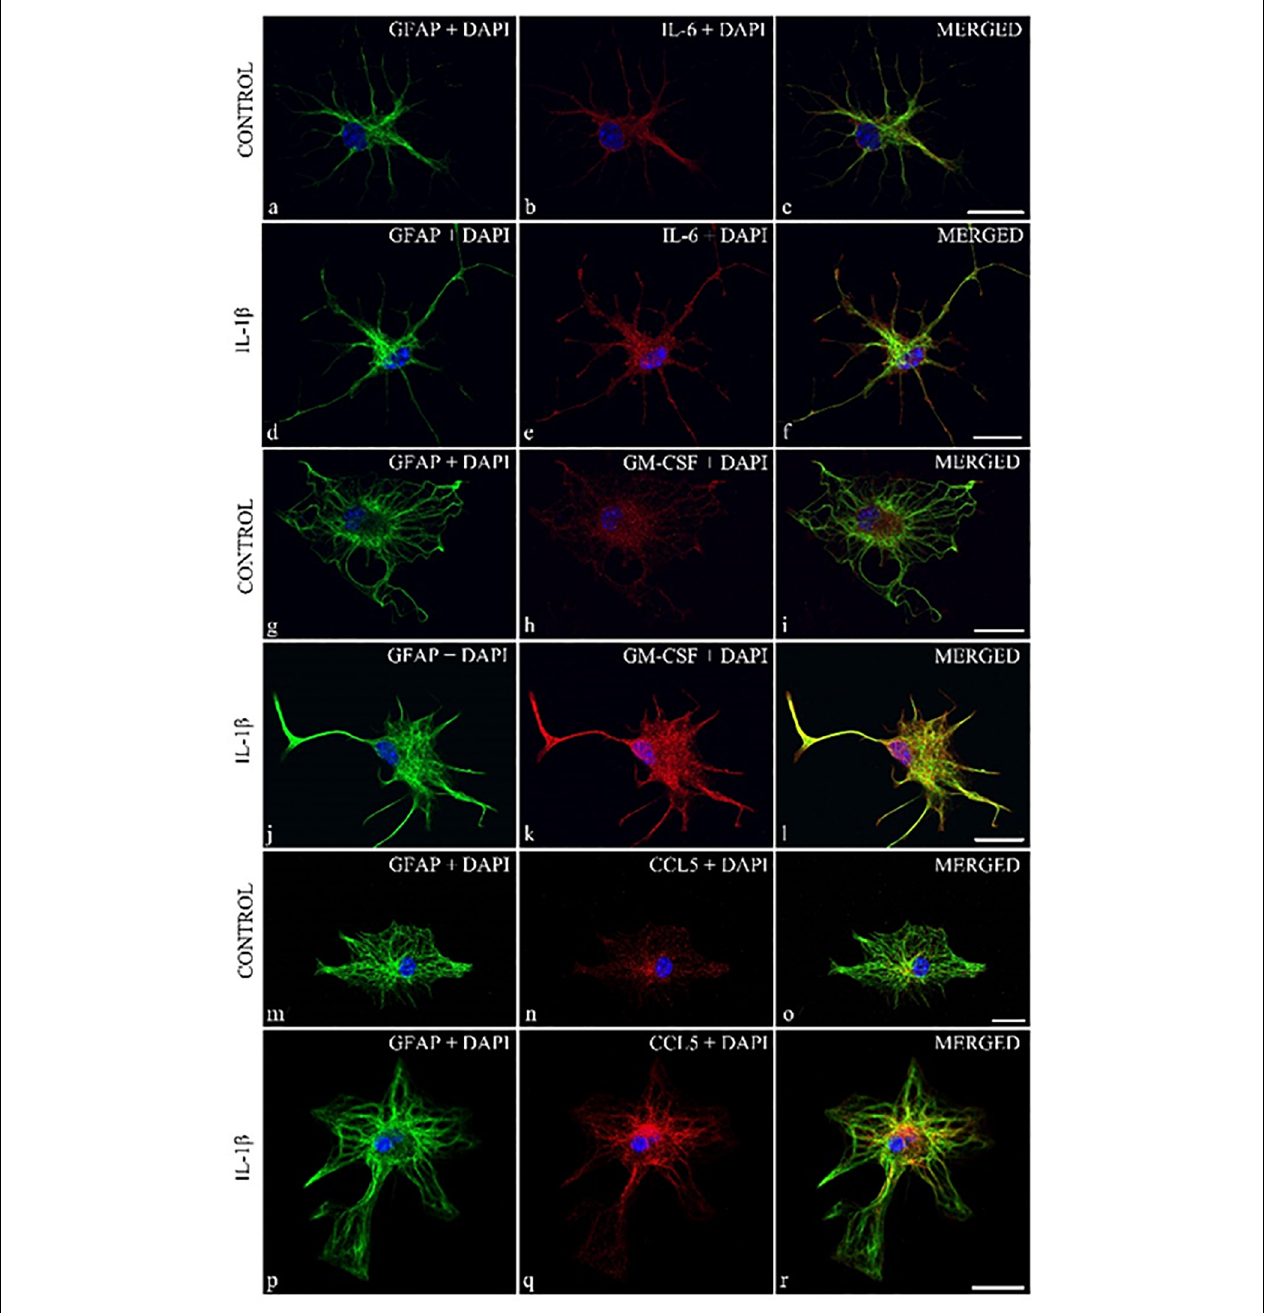
FIGURE 5 | Localization of cytokines in cytoplasmic compartment of GFAP + spinal astrocyte cultures: enhanced cytokine expression was observed in IL-1 β stimulated spinal astrocytes. Micrographs of single 1 µ m thick laser scanning confocal optical sections illustrating co-localization between GFAP astrocytic marker (green) and IL-6, GM-CSF, CCL5 cytokines (red). Panels (a–c , g,h , l–n) represent control, while (d–f,i–k,o–q) show cultures which received 24 h of IL-1 β treatment. Mixed colors (yellow) on the superimposed images (c,f,h,k,n,r) indicate double labeled structures. On all images DAPI was used to label cell nuclei (blue). Scale bar 10 µ